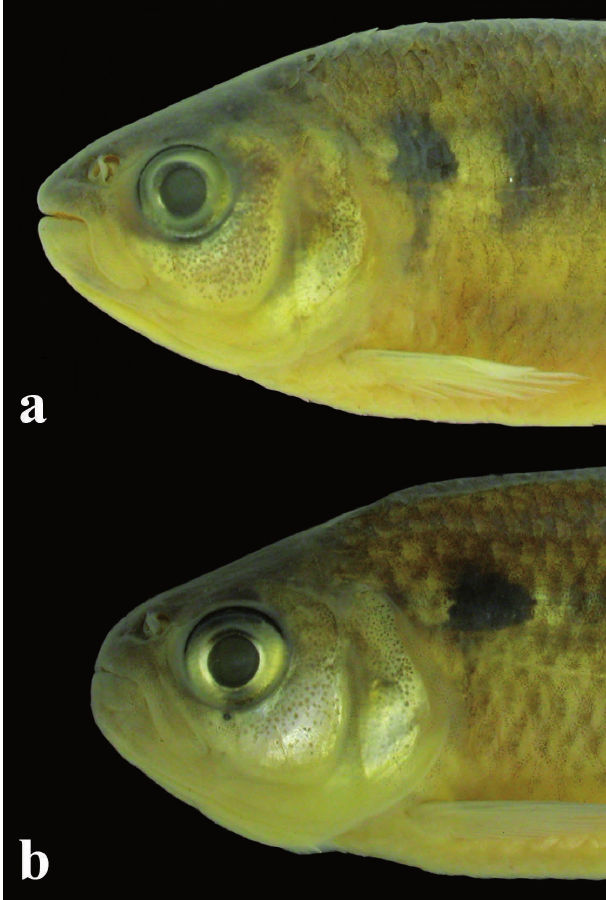
Fig. 4. Lateral view of left side of anterior region showing humeral spots of ( a ) Astyanax obscurus , MCP 26125, 75.6 mm SL, and ( b ) Astyanax laticeps , MCP 26127, 71.1 mm